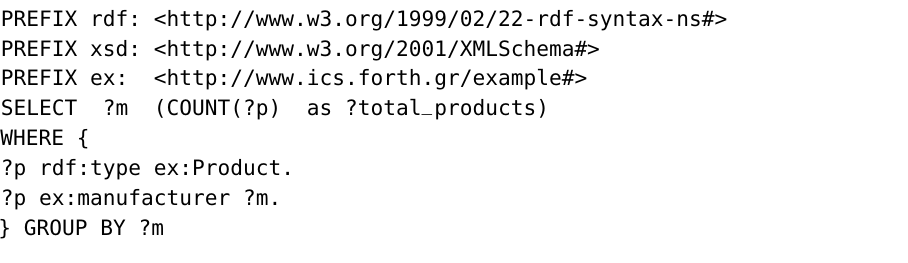
Figure 3. Expression in SPARQL of the query “total quantities of products released by company" .